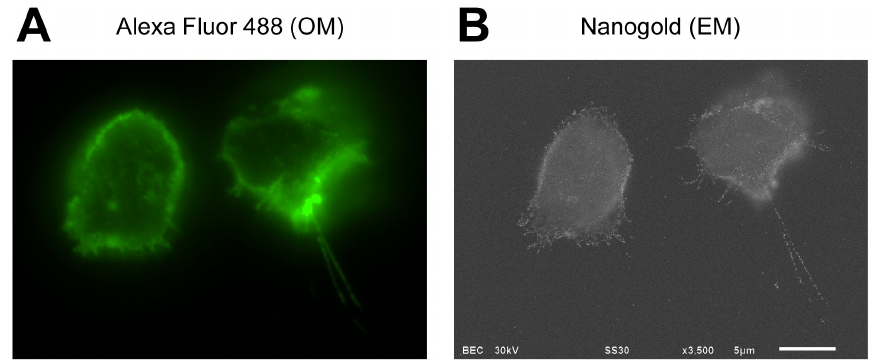
Figure 2. Distribution of CD44 on the plasma membrane, visualized by correlative optical and electron microscopy using ASEM. BW5147 T lymphocytes were labeled with an anti-CD44 monoclonal antibody IM7.8.1, and further with a secondary antibody conjugated both with Alexa Fluor 488 and Nanogold. ( A ) Fluorescence optical microscopy (OM) image; and ( B ) Electron microscopy (EM) image of the same cells after gold enhancement. Signals were clearly observed on the cell body as well as on the microvilli. ASEM images were captured at 3500× magnification. Scale bar represents 5